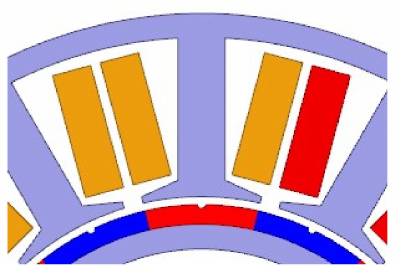
Figure 6. Schematic diagram of slotting rotor magnetic